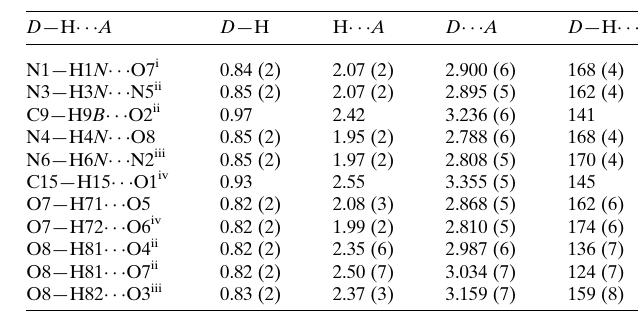
Table 1 Hydrogen-bond geometry (A˚ , (cid:3) ).